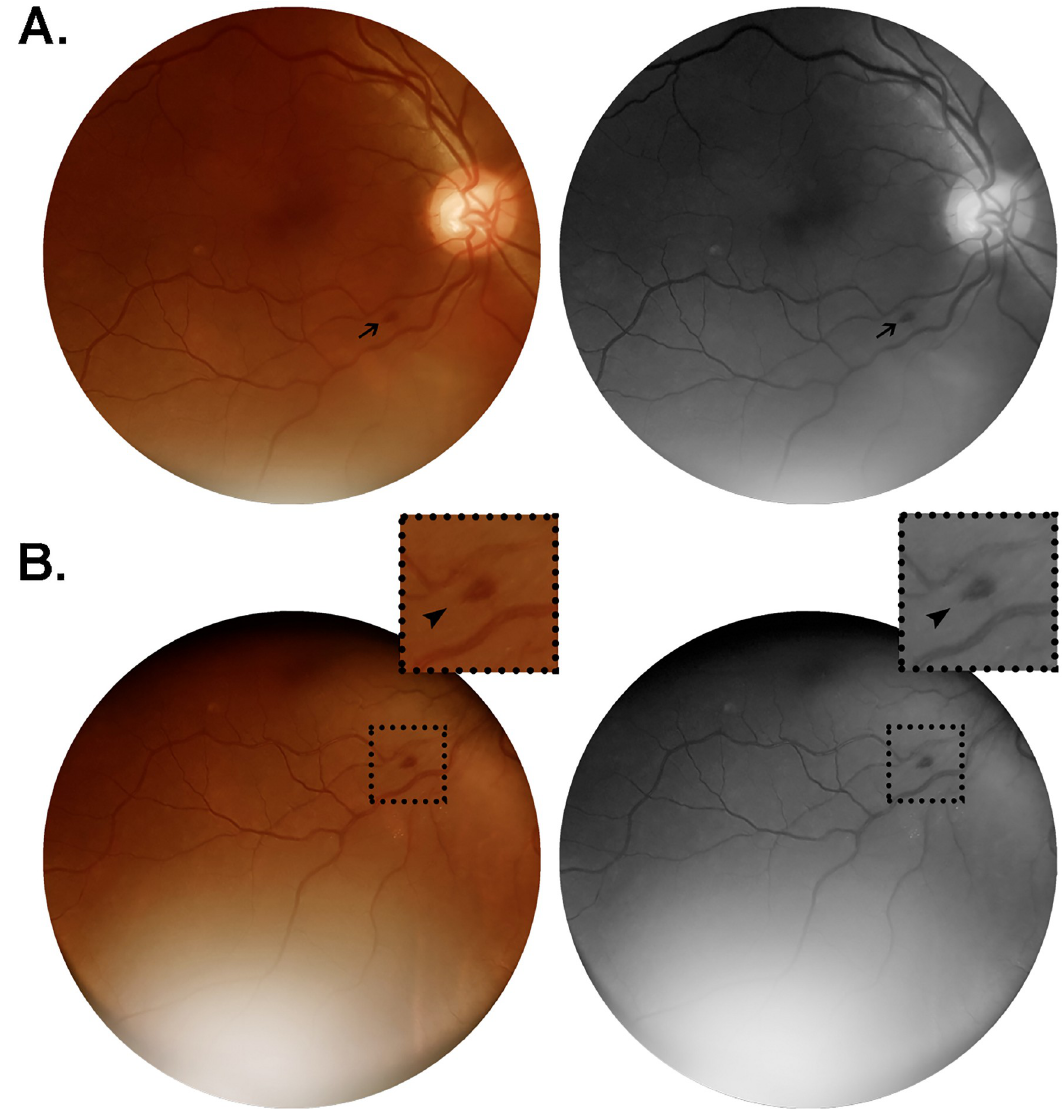
Fig 2. Color and red-free retinal photographs from patient #18 (W.S.). Images acquired on day 16 from symptoms onset, from a 56 year-old man with no comorbidities, admitted on day 13 after onset of a clinical scenario characterized by fever, cough, headache, myalgia and dyspnea. The patient evolved to severe illness, not requiring ICU monitorization nor developing any organ failure. Lung CT at admission revealed bilateral ground-glass opacities predominantly in the periphery, extending to approximately 50% of lung parenchyma. (A) Flame-shaped hemorrhage (arrow) approximately one disc diameter from the optic nerve head, close to the inferior temporal vascular arcade. (B) Same lesion observed from an alternative point of gaze fixation, magnified in the insets (2x;